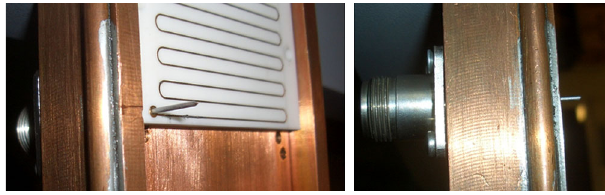
FIG. 14. Pictures of the measurement setup for the meander line of the single bunch selector. Change in the coaxial transition of Port 1.